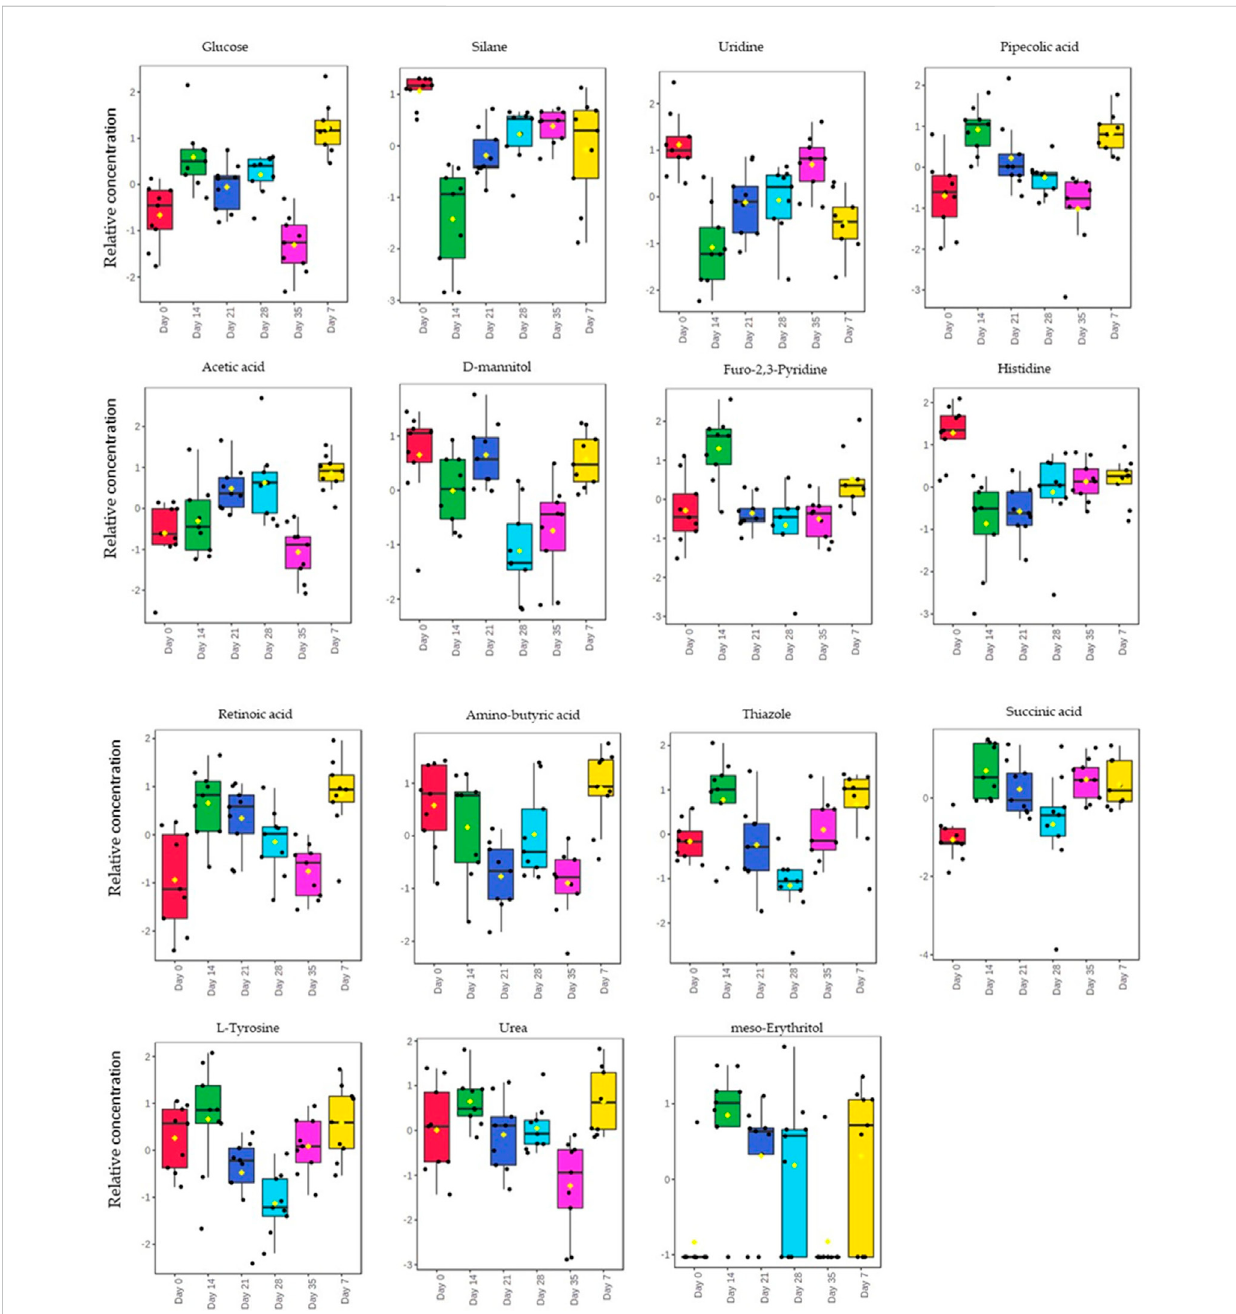
FIGURE 4 Box-Whisker plot for the signi fi cantly different metabolites ( p -value ≤ 0.05). The top 15 signi fi cantly different metabolites identi fi edand their relative concentrations of each plotted against the different days post